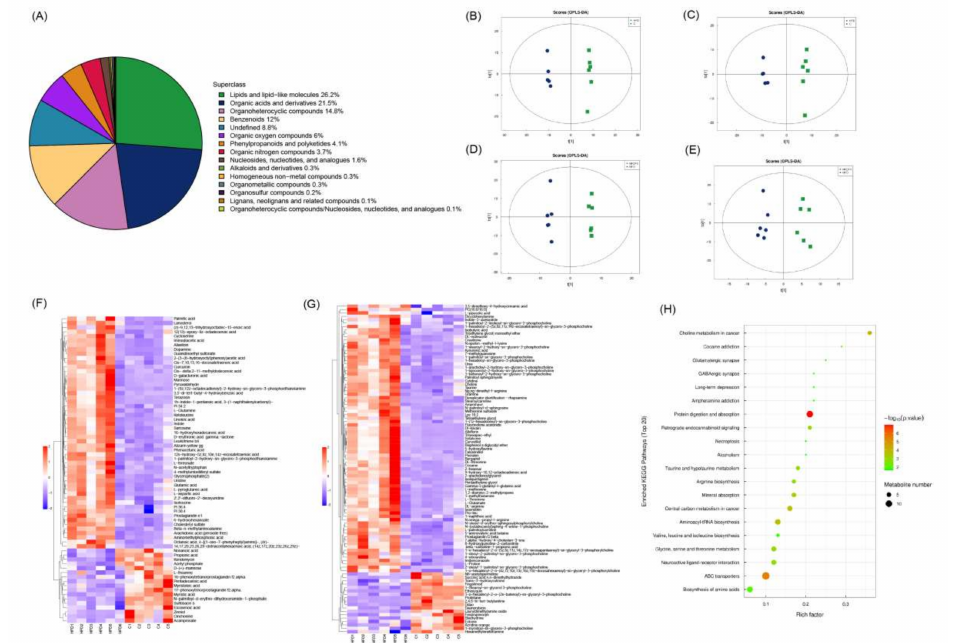
Figure 6. The differential metabolites were determined by untargeted metabolomics. ( A ) The classification of identified metabolites; OPLS-DA analysis HFD vs. CON ( B , C ) and HFDFV vs. HFD ( D , E ) under negative and positive ions model; ( F , G ) Hierarchical clustering of differential metabolites in HFD vs. CON under negative and positive ions, respectively; ( H ) KEGG enrichment analysis of HFD vs.